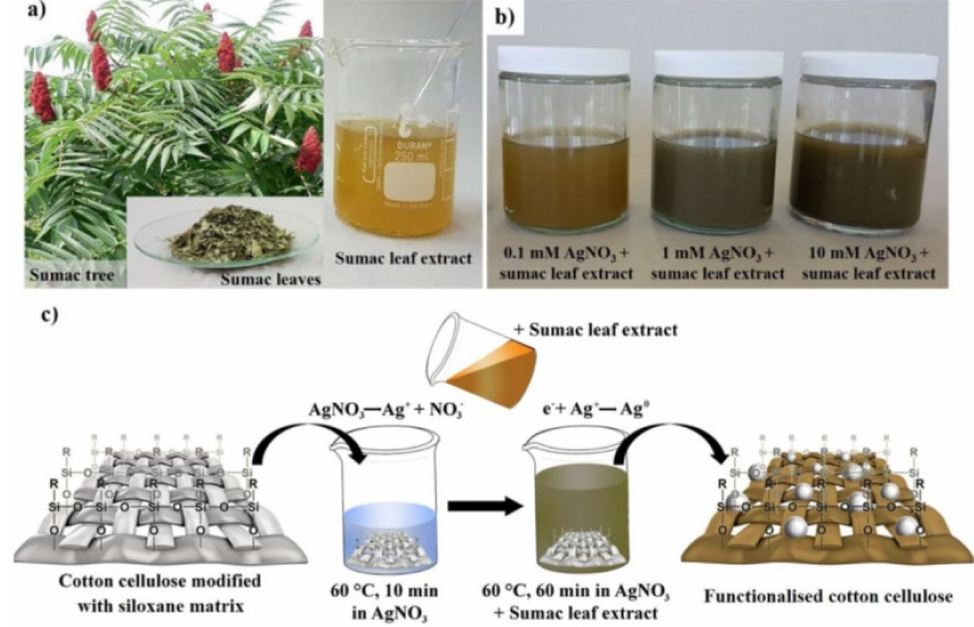
Figure 5. ( a ) preparation of sumac leaf extract; ( b ) different concentrations of AgNO 3 with sumac leaf extract colloidal solutions; ( c ) schematic representation of in situ biosynthesis of AgNPs on cotton cellulose [89]. Creative Commons CC-BY license,